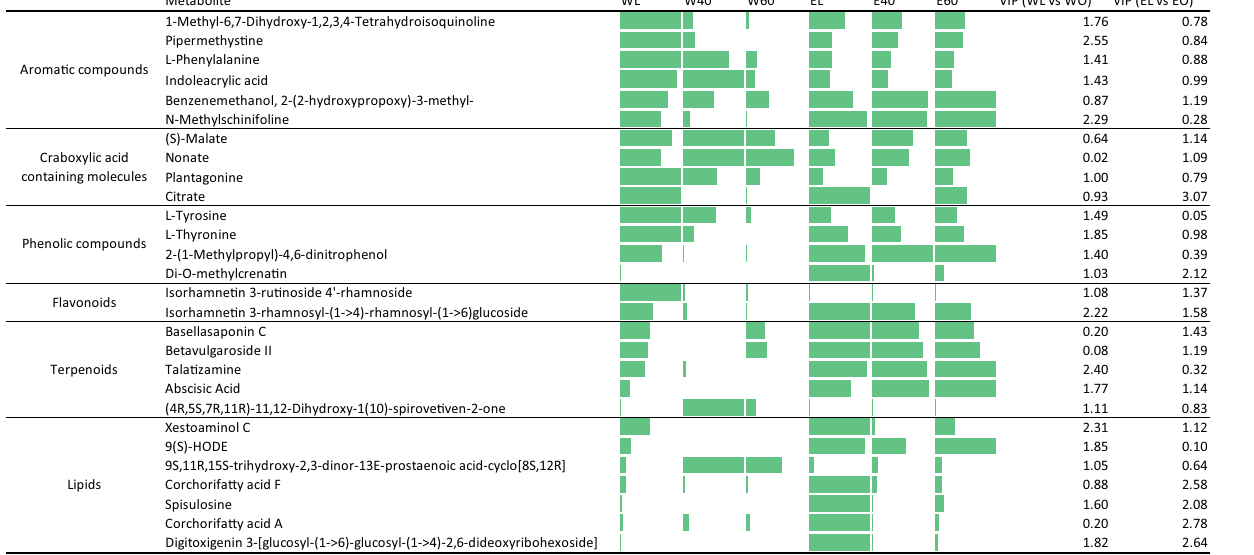
Table 1. Top 20 most annotated metabolites extracted from A.macrostachyum under different conditions and their corresponding abundance in each sample All the presented metabolites showed VIP score ≥ 1 in the contribution to the variability between lyophilized and oven-dried samples. WL: lyophilized water extract, WO: oven-dried water extract, W40: oven-dried water extract at 40 °C, W60: oven-dried water extract at 60 °C, EL: lyophilized 50% EtOH extract, EO: oven-dried 50% EtOH extract, E40: oven-dried 50% EtOH extract at 40 °C, E60: oven-dried 50% EtOH extract at 60